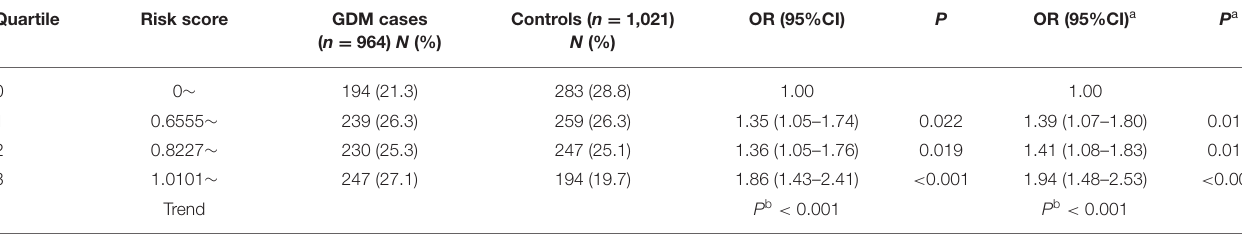
TABLE 5 | Risk stratification for GDM using genetic risk score.